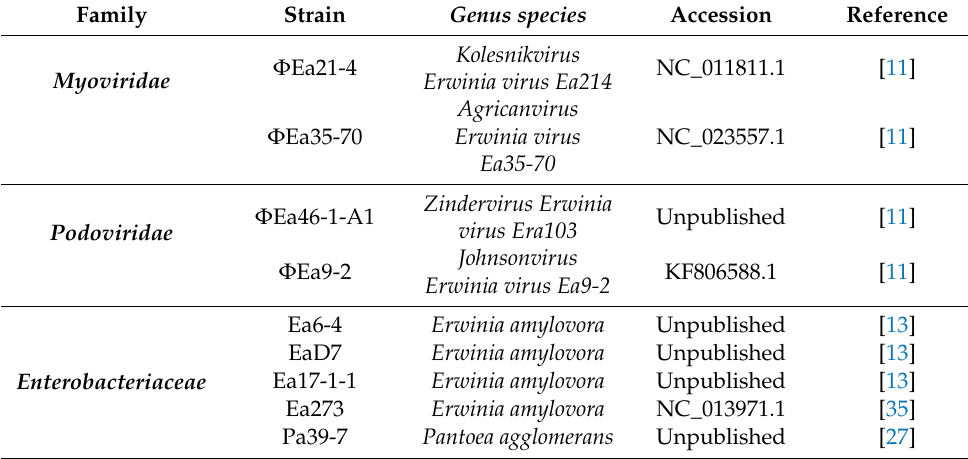
Table 2. Phage and bacterial isolates used in this